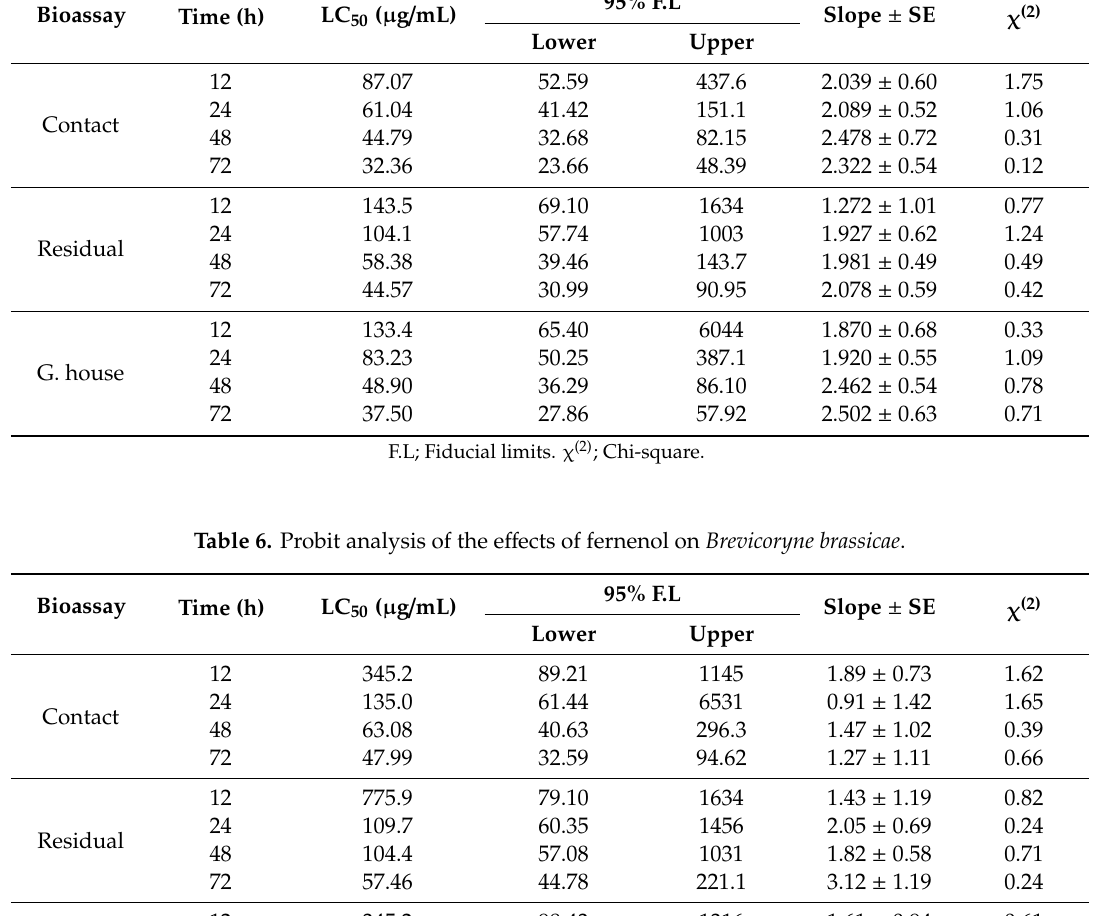
Table 5. Probit analysis of the e ff ects of spinasterol, 22,23-dihydrospinasterol on Brevicoryne brassicae. Bioassay